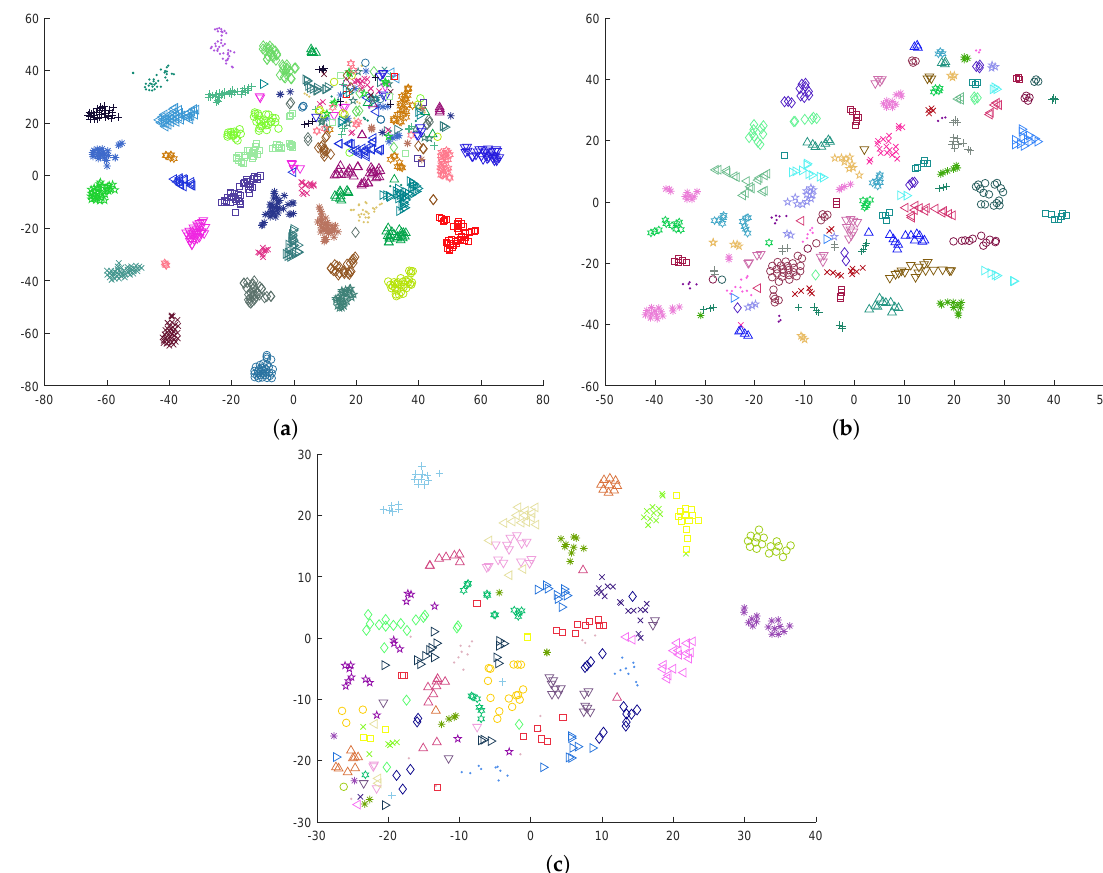
Figure 2. Dimensionality reduction by t-SNE, after normalizing the data by scaling each feature between the maximum and minimum values for the particular subject: ( a ) DEAP; ( b ) MAHNOB-HCI; and ( c )